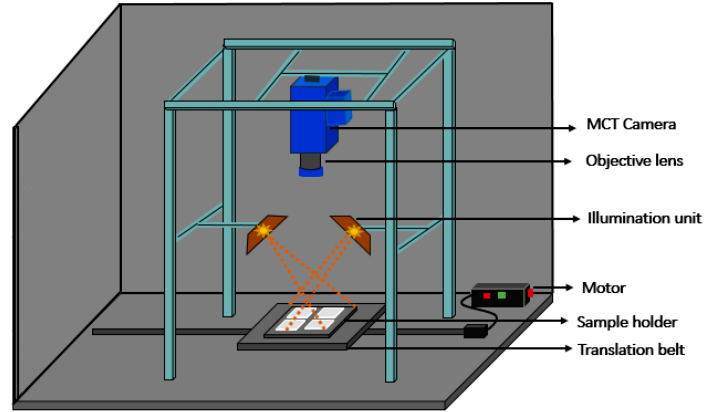
Figure 2. Schematic diagram of the hyperspectral imaging set up for spectral image acquisition of the radish slabs.